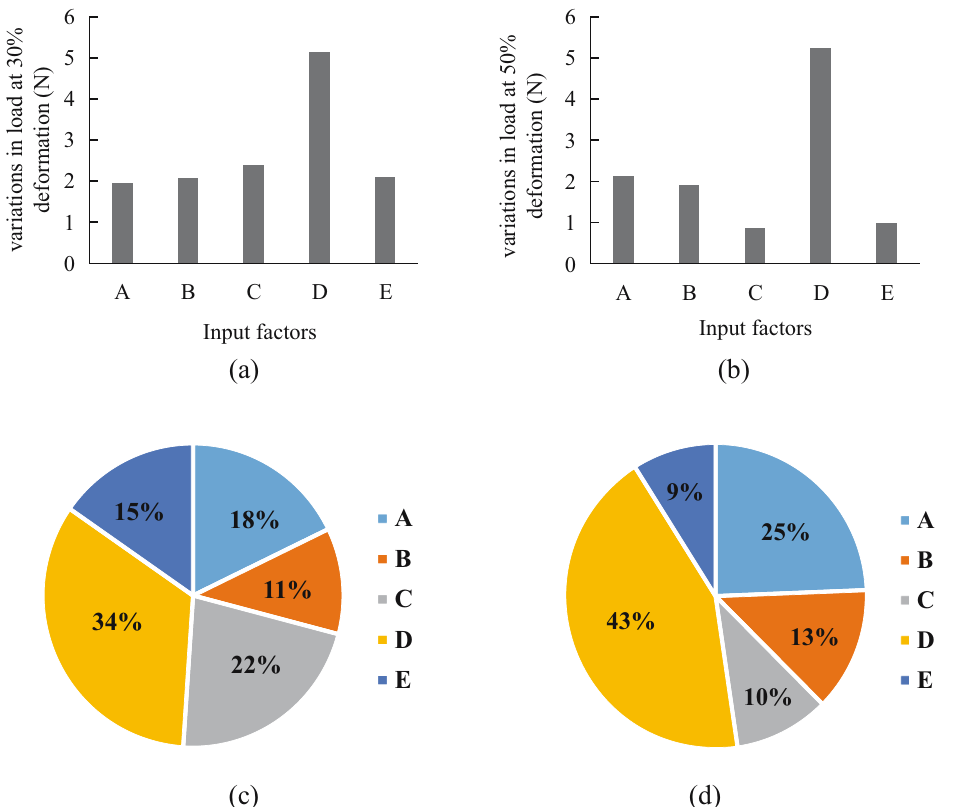
Figure 3: Diagram of the range value on compression load at 30% ( a ) and 50% ( b ) deformation of the original diameter and normalized at 30% ( c ) and 50% ( d ) of diameter deformation to various input factors. A – PET strip modulus ( GPa ) , B – number of nitinol wire, C – initial braiding angle ( ° ) , D – nitinol wire diameter ( mm ) , and E – PET strip thickness ( mm )